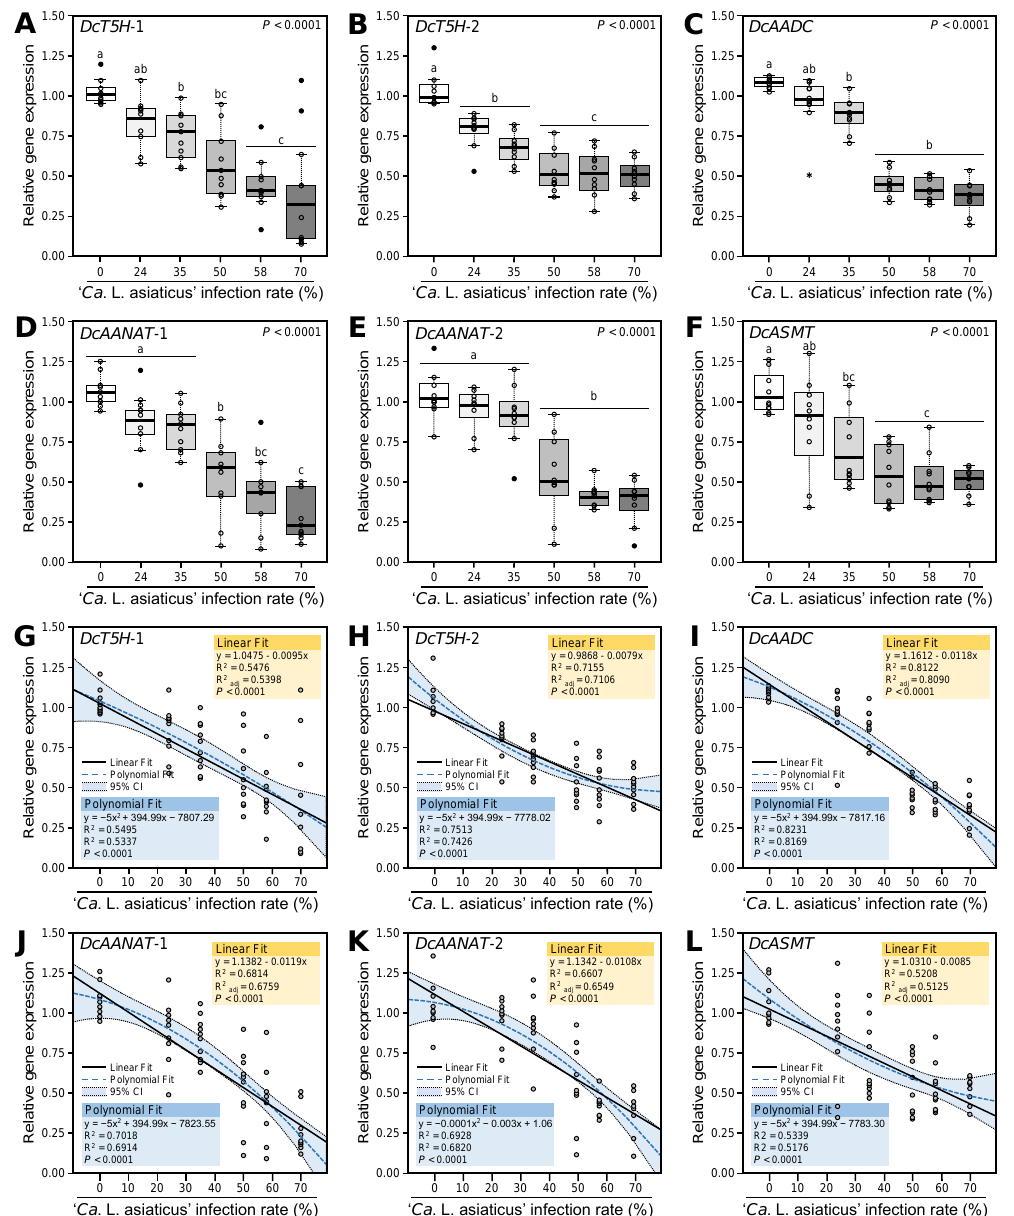
Figure 14. Effect of different infection rates with Candidatus Liberibacter asiaticus on melatonin biosynthesis-related genes of Diaphorina citri. ( A – F ) Relative gene expression of tryptophan 5-hydroxylase ( DcT5H -1 and DcT5H -2), aromatic amino acid decarboxylase ( DcAADC ), arylalkylamine N -acetyltransferase genes ( DcAANAT -1 and DcAANAT -2), and N -acetylserotonin O-methyltransferase ( DcASMT ), respectively. Gene expressions were normalized using two housekeeping genes ( α -tubulin and actin), and the changes were analyzed using the 2 −ΔΔ C T method. Open dots indicate the raw data ( n = 10), the black ones indicate potential outliers, whereas horizontal thick lines indicate the medians. Whiskers indicate the minimum, and the maximum values of the data and boxes show the interquartile ranges (twenty-fifth to the seventy-fifth percentile of the data). Different letters indicate statistically significant differences among different infection rates, while the same letter signifies no significant differences between them using Tukey–Kramer honestly significant difference test (Tukey HSD; p < 0.05). The full list of expressed genes, names, accession numbers, and primers are available in Table 1. ( G – L ) Simple linear regression and quadratic polynomial regression analysis between Ca. L. asiaticus infection rates and the expression levels of DcT5H -1, DcT5H -2, DcAADC , DcAANAT -1, DcAANAT -2, and DcASMT , respectively. Open dots present the row data ( n = 10). The fitted regression line is presented as a black solid-line, while the polynomial regression model is presented as a blue dashed line. The 95% confidence intervals (95% CI) for the estimated polynomial regression are blue-shaded and edged by doted-lines. Regression equations, R 2 , R 2 adj , and p -value based on the F test ( p < 0.05) were also obtained and presented within the graph.